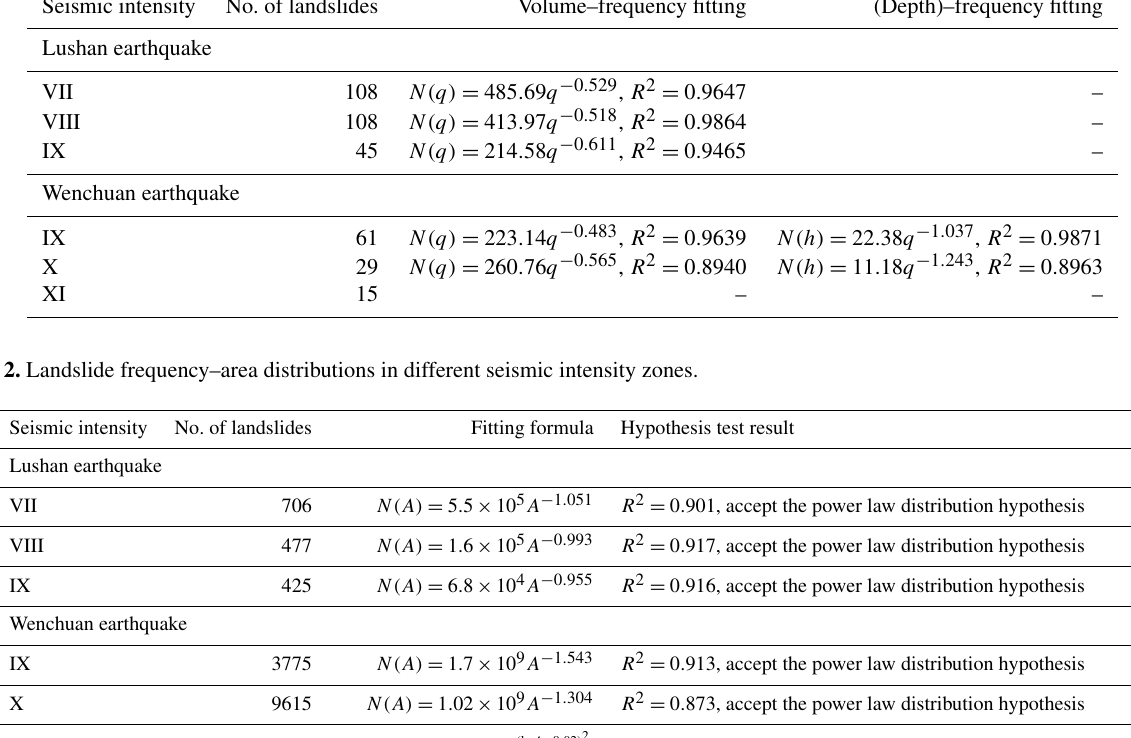
Table 1. Landslide volume (depth)–frequency distributions in different seismic intensity zones. Seismic intensity